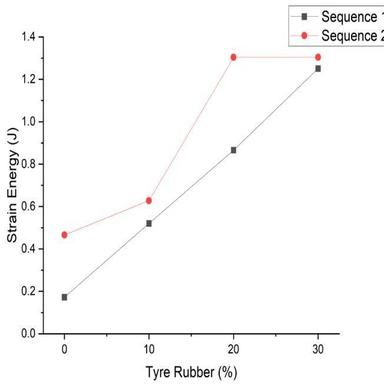
Variation in strain energy at sequence 1 and sequence 2 for the different mixes.